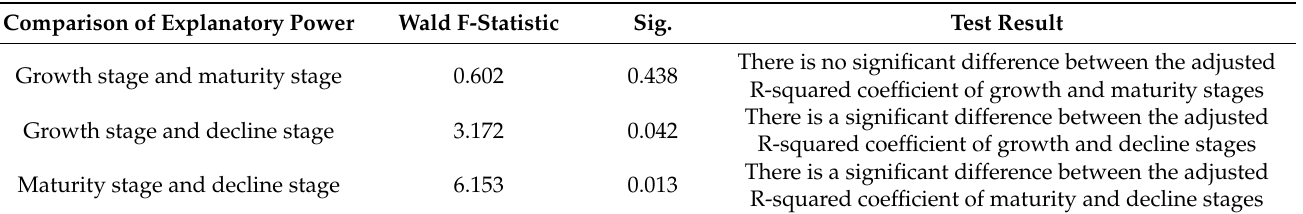
Table 11. Survey the significance of the difference in the adjusted R-squared coefficient of the regression models according to the firms’ life cycle for the first hypothesis (Wald